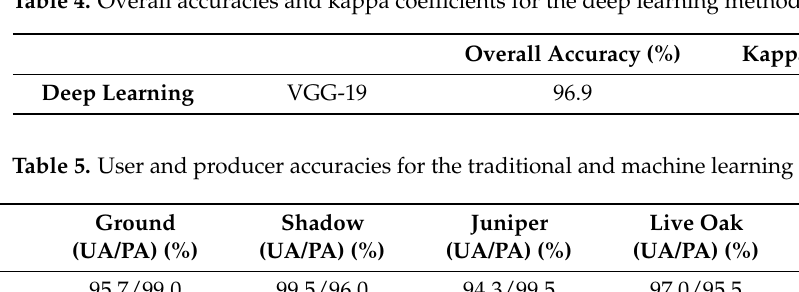
Table 4. Overall accuracies and kappa coefficients for the deep learning method .